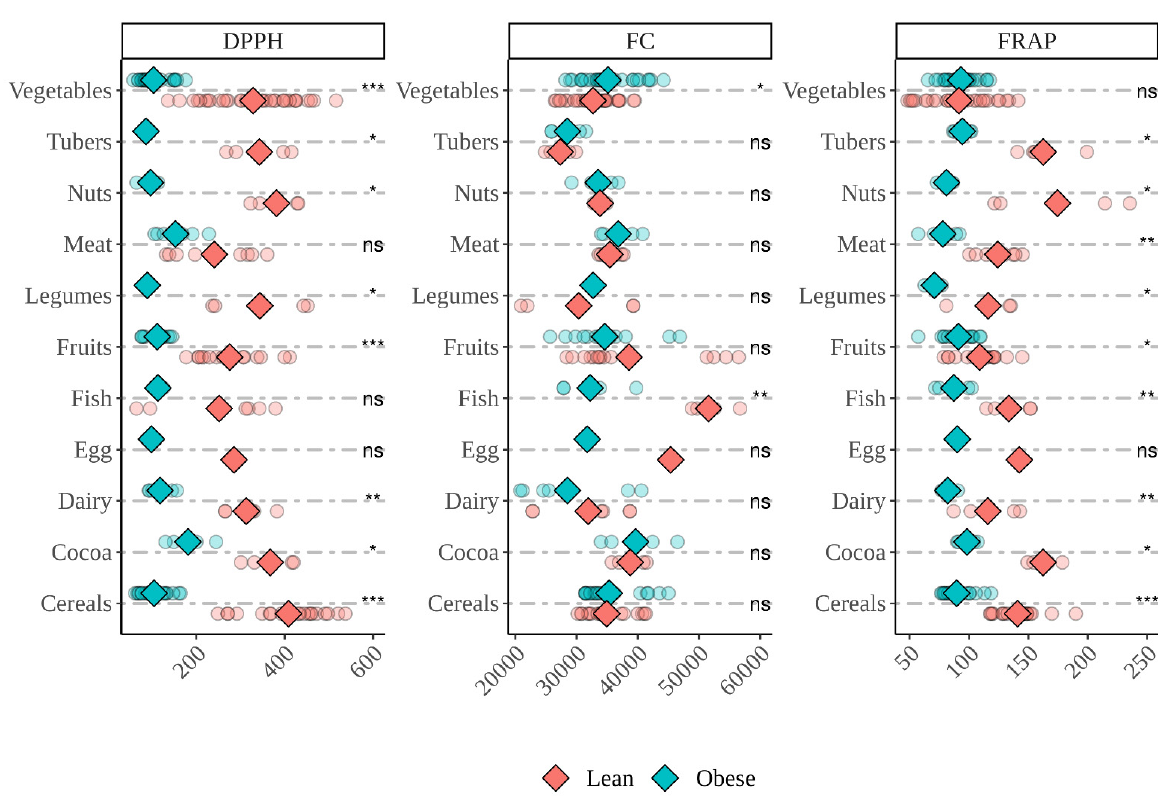
Figure 7. Comparison between the antioxidant capacity of different food groups after in vitro fermentation with fecal material from obese and lean children. DPPH expressed as mmol Trolox equivalents/kg(L) of food; Folin–Ciocalteu (FC) expressed as mg equivalents of gallic acid/kg(L) of food; FRAP expressed as mmol Trolox equivalents/kg(L) of food. Diamonds represent the mean antioxidant capacity of each group. Dots represent the antioxidant capacity of each food within the group. Statistical analysis was performed via Kruskal–Wallis test. Comparisons were made using “Lean” as the reference group. Statistic labels: *— p < 0.05, **— p < 0.01, ***— p < 0.001, ns—not significant.